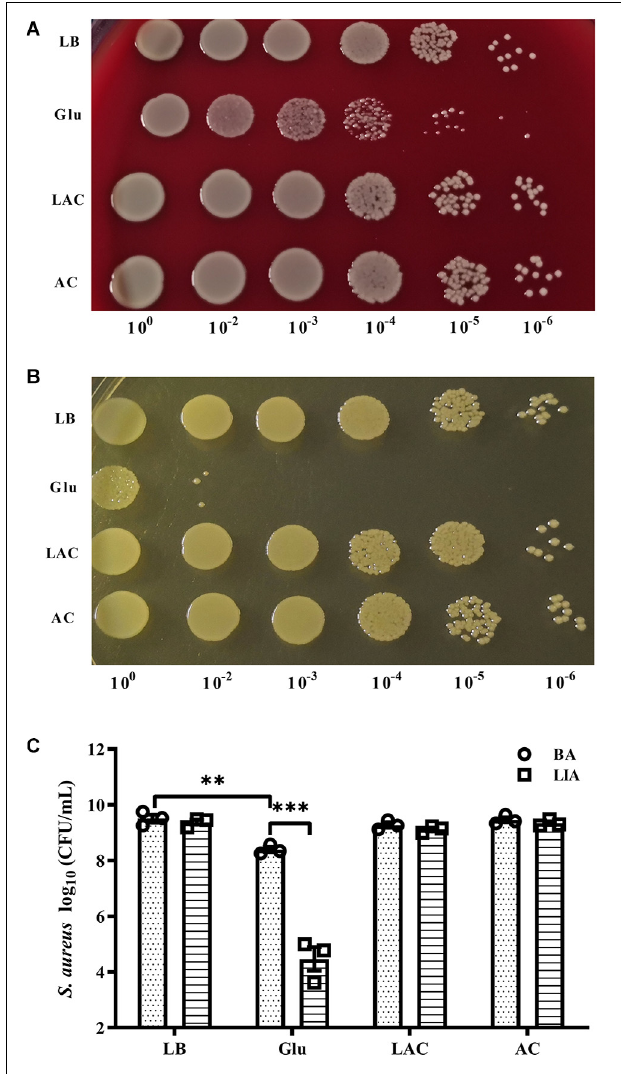
FIGURE 3 | Survival of S. aureus Newman was unaffected by organic acid. S. aureus Newman was grown overnight in LB medium, then 25 mM glucose, 20 mM lactic acid, or 20 mM acetic acid was added to the medium and the cultures were incubated for a further 48 h. CFUs were then determined by serial dilution and plating on BA (A,C) and LIA plates (B,C) . ∗∗ p < 0.01; ∗∗∗ p <